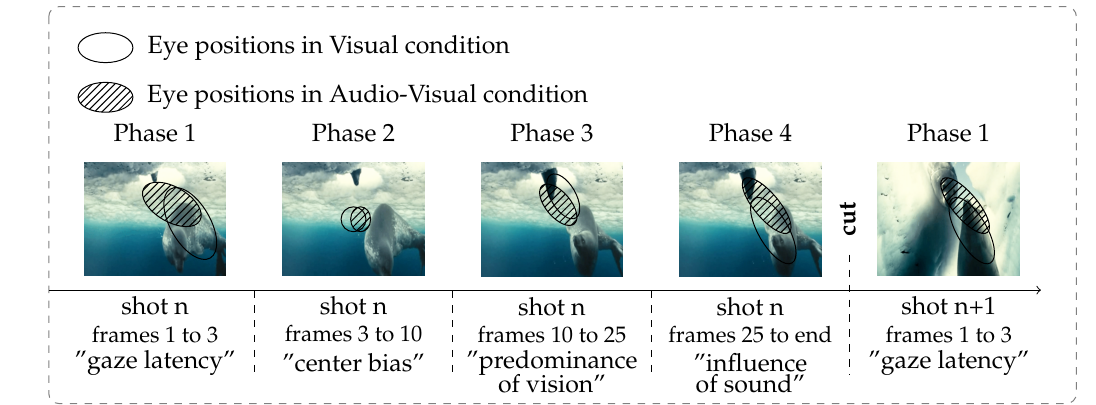
Figure 6 . Schematic representation of the four temporal phases of eye movements across a shot. The ellipses represent the location and the dispersion of the two sets of eye positions (V and AV). They were computed using Principal Component Analysis, their axes correspond to the two principal components: the larger axe gives similar values to the dispersion. They are centered at the barycenter of the two sets of eye